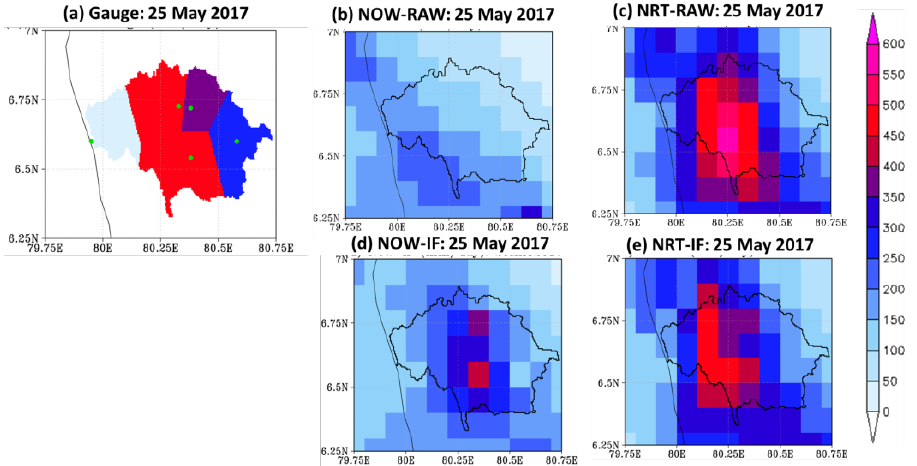
Figure 8. Comparison of daily cumulative rainfall (mm/day) distributions on 25 May 2017 for ( a ) real-time ground data; ( b ) GSMaP-NOW; ( c ) GSMaP-NRT; ( d ) bias-corrected GSMaP-NOW (NOW-IF); and ( e ) bias-corrected GSMaP-NRT (NRT-IF).